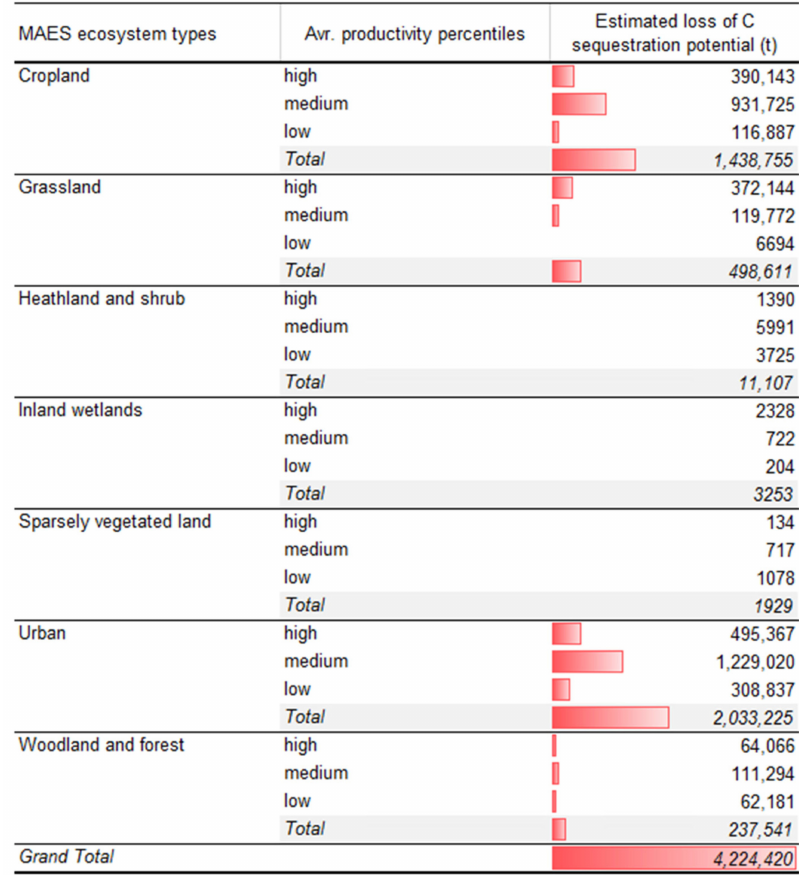
Figure 4. Estimated loss of potential carbon sequestration in Functional Urban Areas because of sealing during 2012–2008, by ecosystems and land